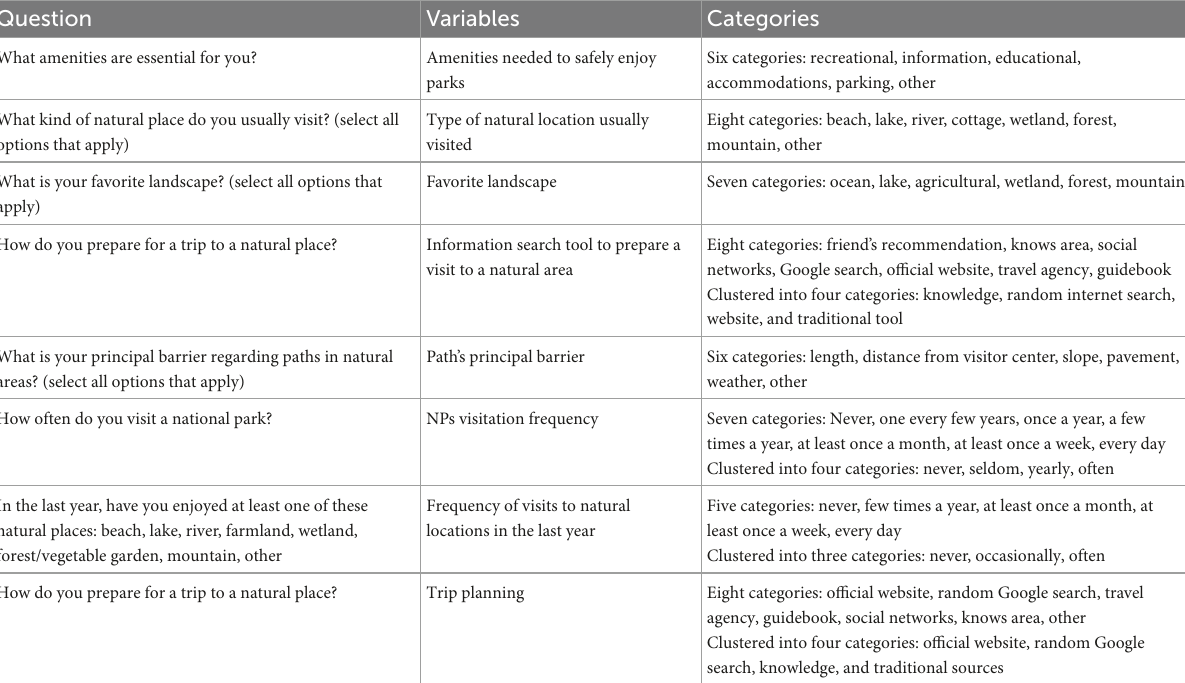
TABLE 2 Questionnaire’s questions, their variables, and categories in section 2.